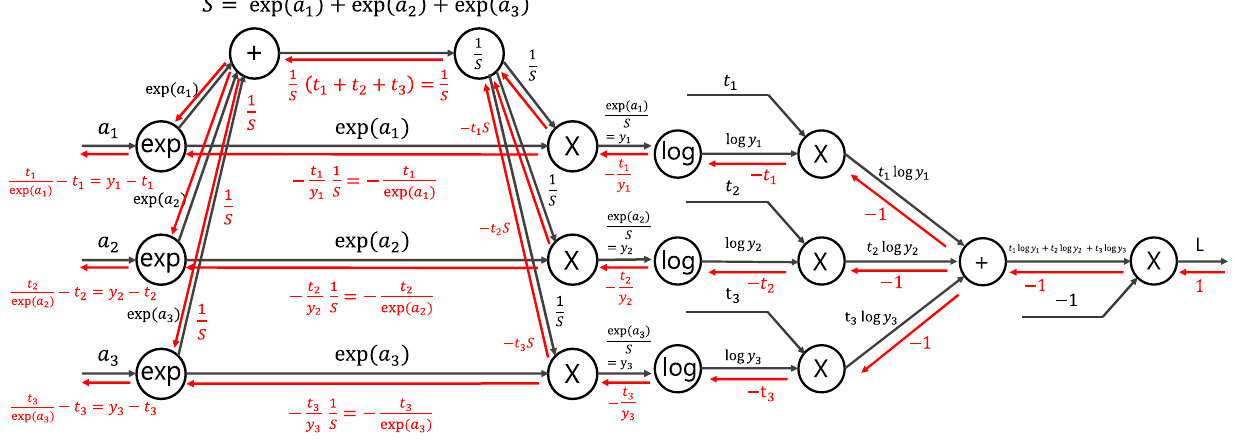
Figure 8. Operation of Softmax and cross entropy error function.